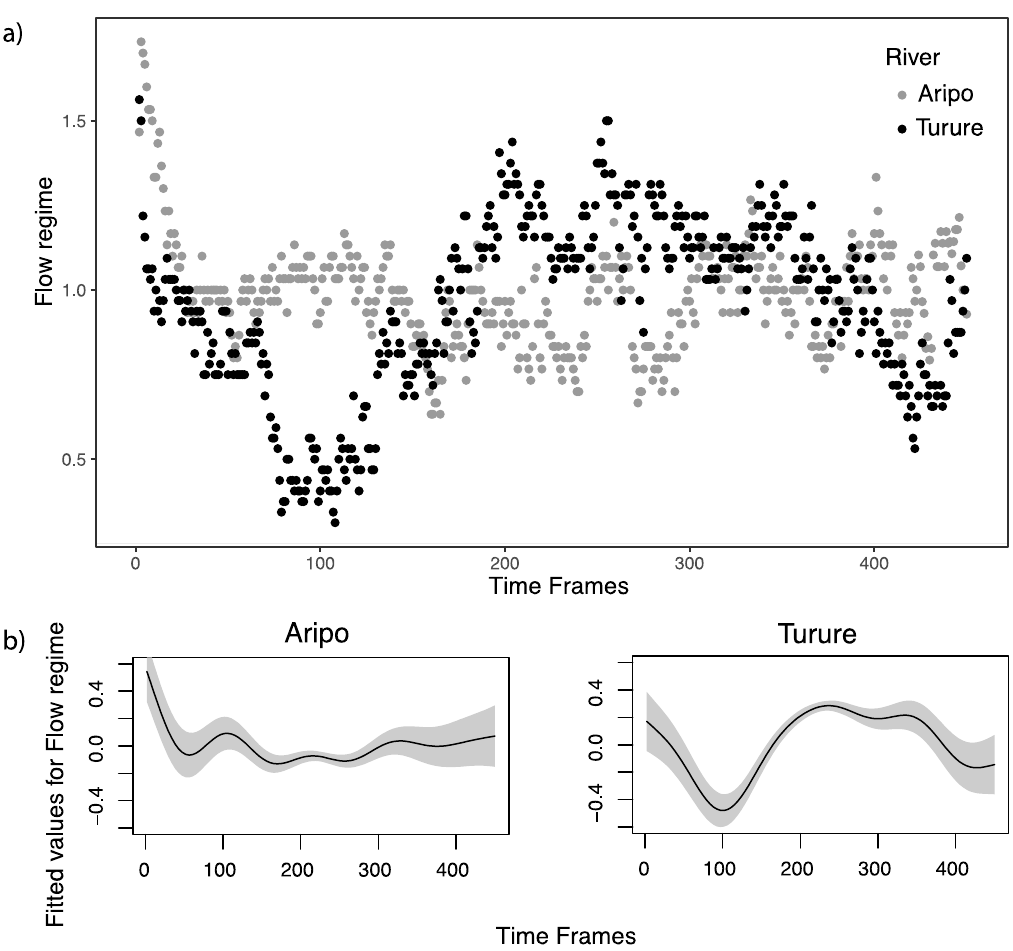
Figure 4. Values for flow regime during the entire duration of the trial (450 time frames over 5 min). ( a ) Individual values averaged at each time frame for each river across all pool types show a different behavioral pattern. High values mean that fish are swimming in higher flow zones. ( b ) Fitted values with GAM for the two rivers, the grey areas represent 95% confidence bands. Values are centered around 0.